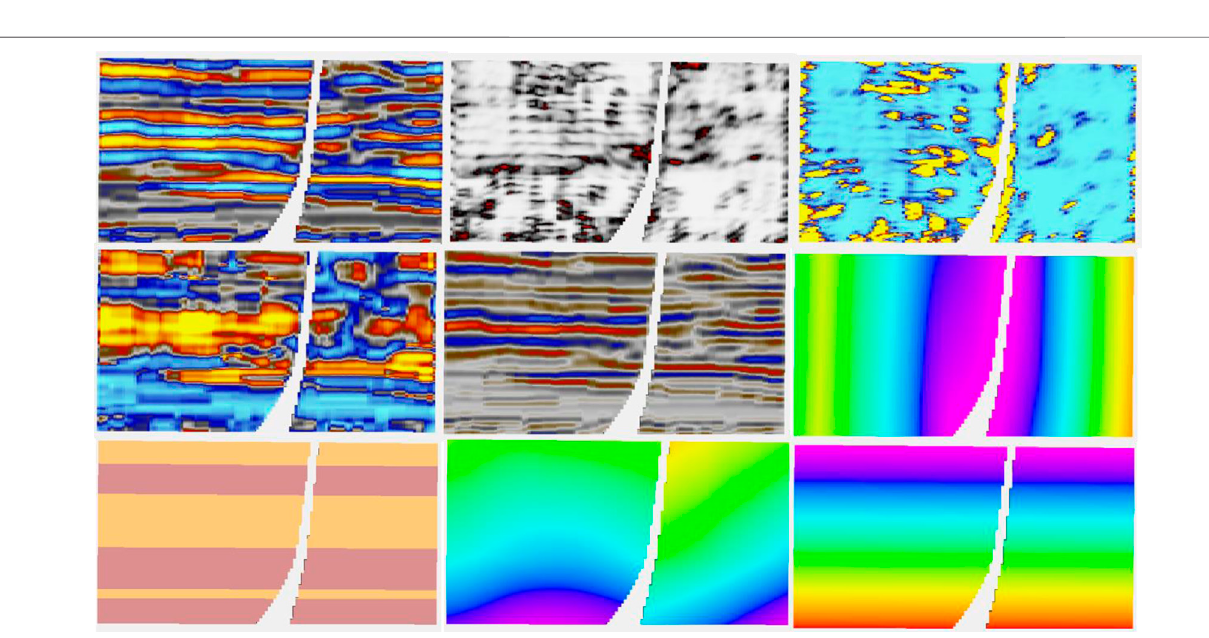
Frontiers in Arti fi cial Intelligence |